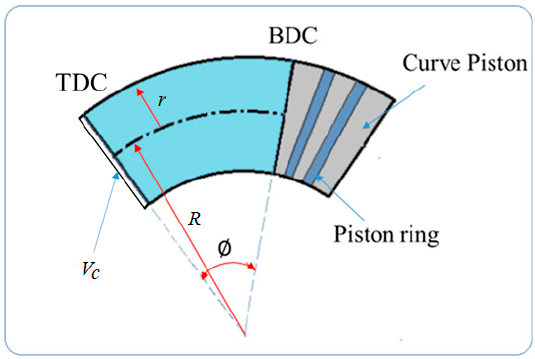
Figure 3. The torus cylinder geometry.